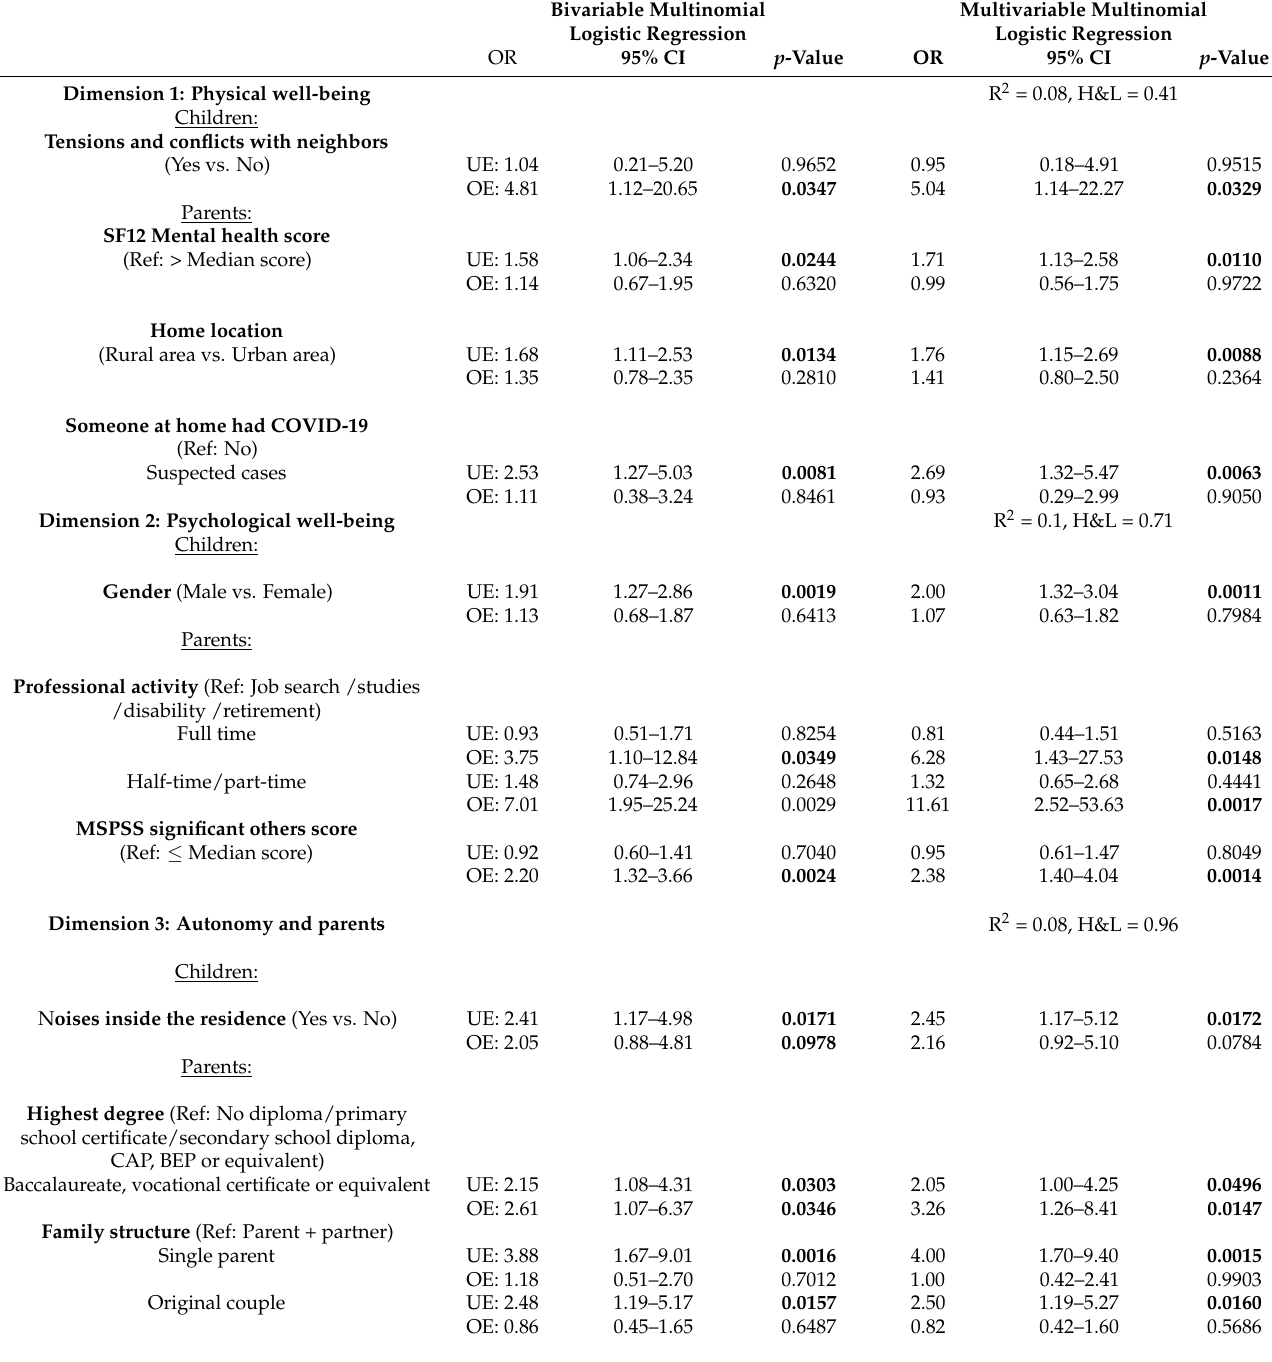
Table 5. Factors associated with discrepancy between children’s quality of life scores assessed by themselves and their parents in each dimension of the KIDSCREEN-27 (N = 471). Bivariable Multinomial Multivariable Multinomial Logistic Regression Logistic Regression OR 95% CI p -Value OR 95% CI p